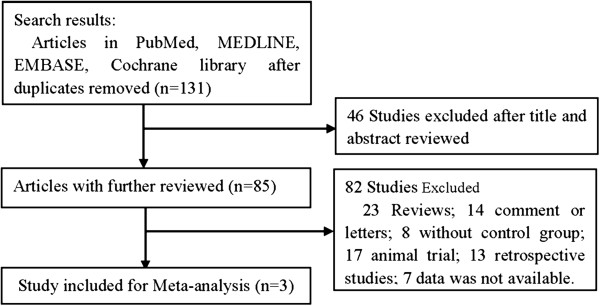
Flow diagram of study selection process.